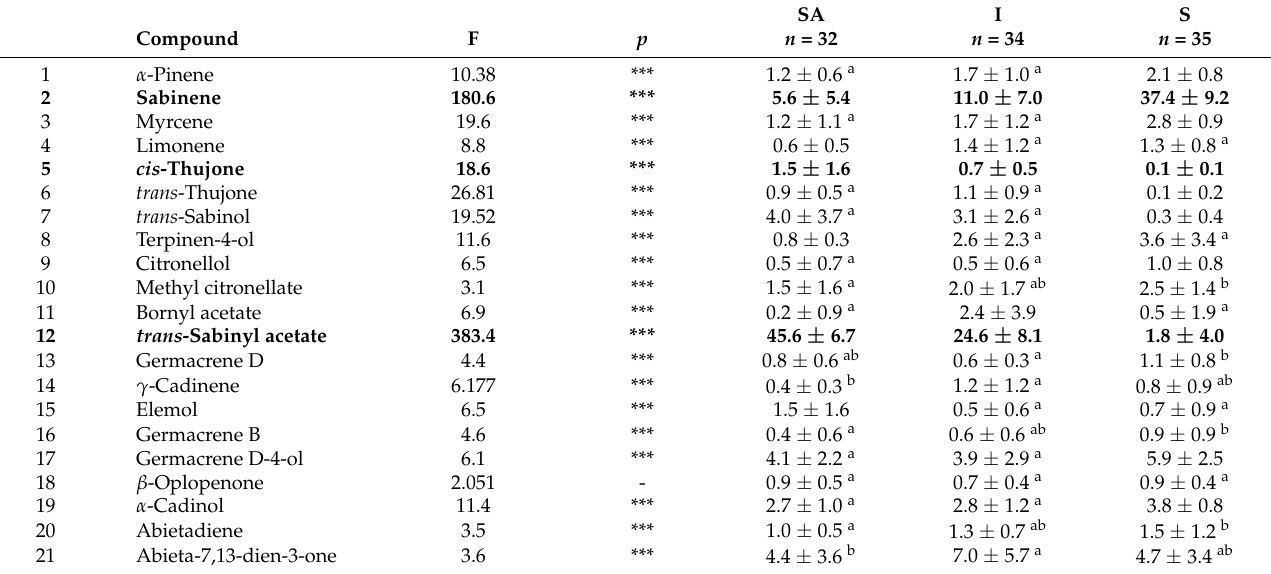
Table 2. ANOVA of three detected chemotypes of leaf essential oil of Junuperus sabina var. balkanensis from the